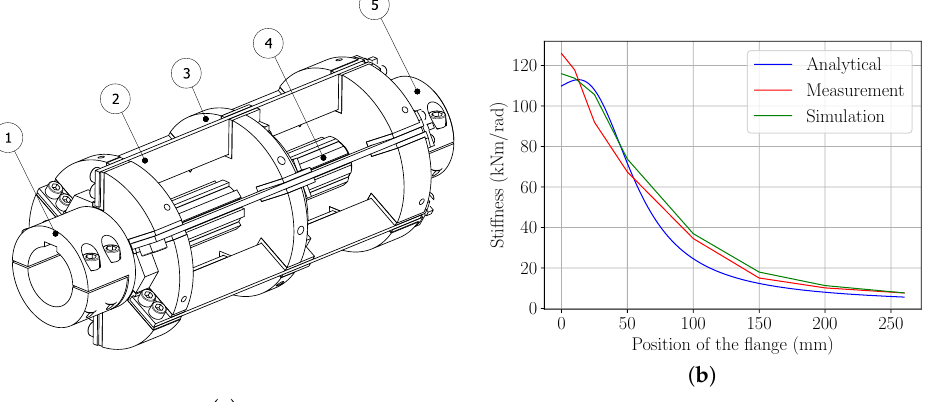
Figure 2. The coupling design and its torsional stiffness. ( a ) The main parts of the coupling from [11]. 1. Input half, 2. Beam, 3. Adjustable flange, 4. Middle shaft, 5. Output half. ( b ) Torsional stiffness curves from analytical calculations, FEM simulations and experimental measurements from [11]. The stiffness values are plotted as a function of the adjustable flange